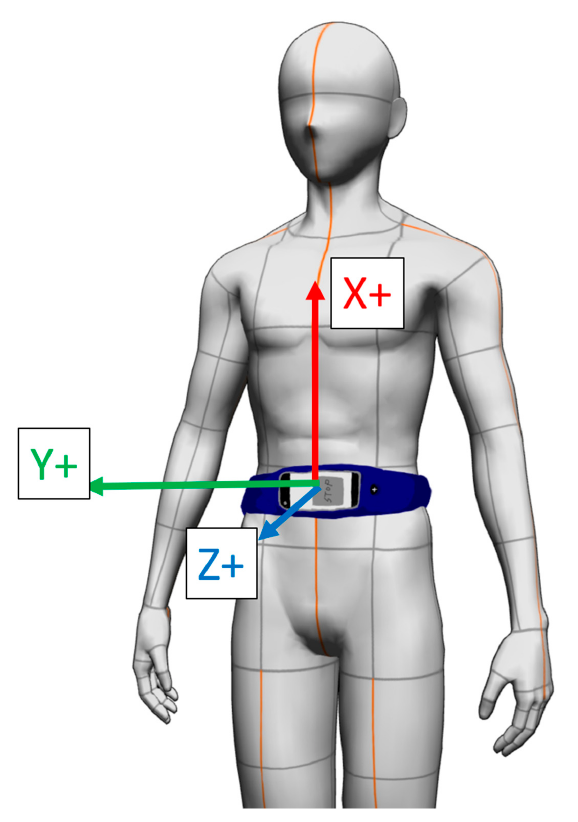
Figure 1. The orientation of the smartphone.